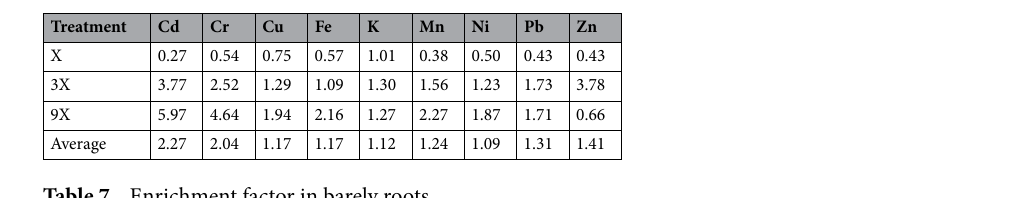
Table 7. Enrichment factor in barely